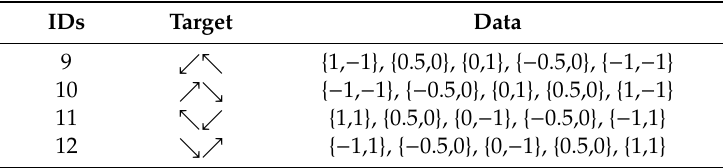
Figure 9. Four recognition targets for vertical V-shaped recognition targets.